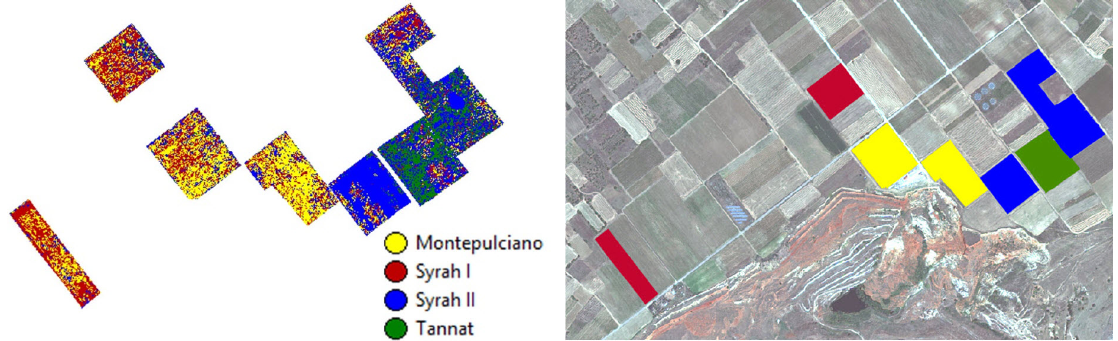
Figure 8. The classification result (left) in an experiment on the multispectral dataset (2-m resolution) with four varieties, in the Amynteo study area, and the corresponding ground truth data